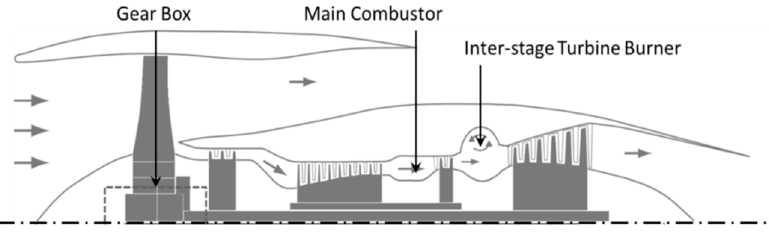
Figure 1. Dual-combustor engine concept developed on the AHEAD project [22].